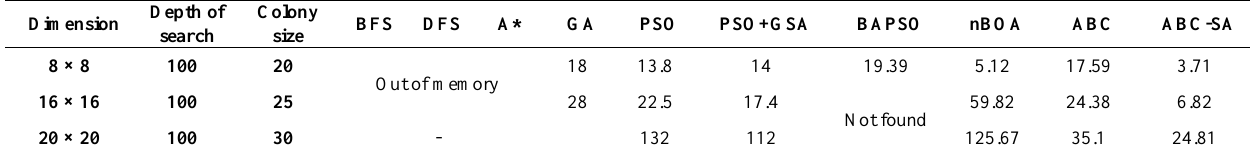
Table 4. Experimental results of different approaches to the N-Queen problem (average response time (s)). Dimension